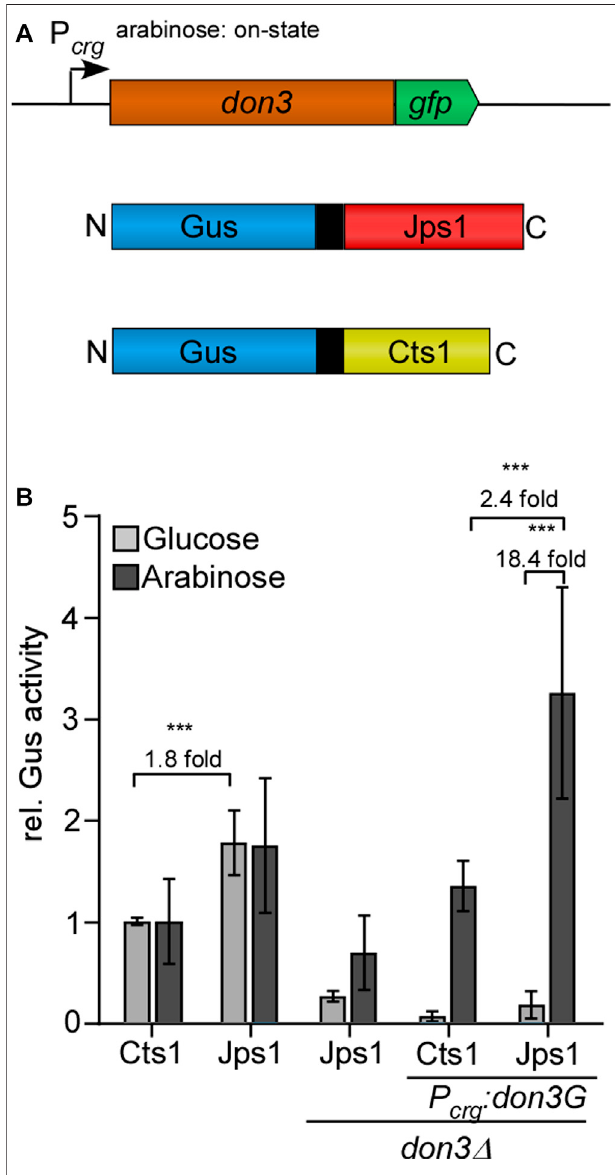
FIGURE 2 | Inducible secretion of Gus-Jps1 via transcriptional regulation of don3 . (A) Schematic display of the inducible secretion system. don3-gfp isexpressedundercontrolofthearabinose-induciblepromoterP crg . Under glucose conditions the promoter is in its “ off state ” , unconventionally secreted proteins under control of P oma are thus expressed but not secreted. Under arabinose condition the promoter is in its “ on state ” and proteins are secreted. Gus is fused to either Cts1 or Jps1 including an internal SHH tag (double Strep, ten times His, triple HA). (B) Gus activity in culture supernatants of AB33 derivatives expressing Gus-Cts1 or Gus-Jps1 and their Δ don3 variants. Enzymaticactivity wasnormalized toaveragevalues ofpositivecontrolssecretingGus-Cts1constitutively.Thediagramrepresents the results of three biological replicates. Error bars depict standard deviation. Fold change of induced cultures depicted over brackets. De fi nition of statistical signi fi cance (***): p -value < 0.05. p -value derived from Student ’ s unpaired t